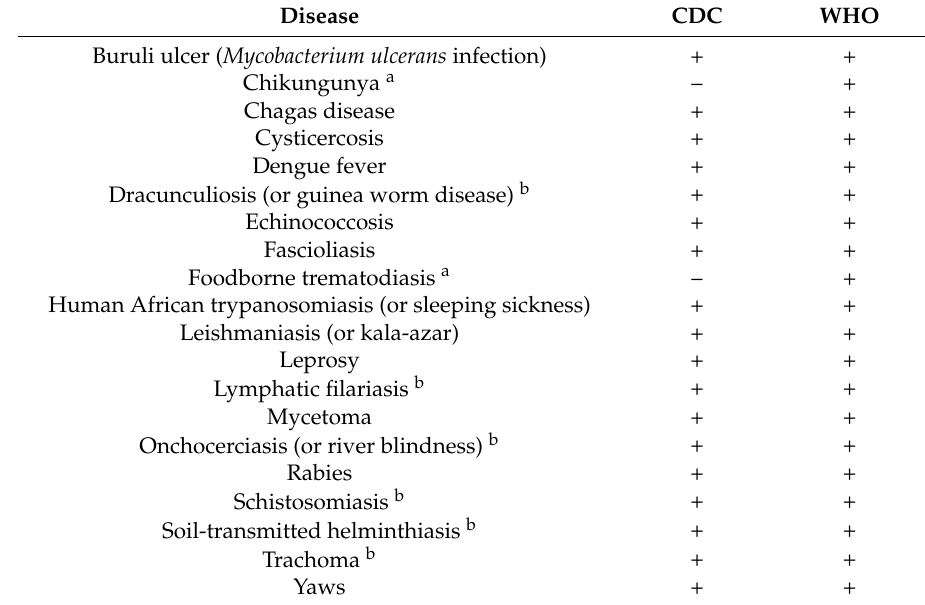
Table 1. List of Neglected Tropical Diseases by Centers for Disease Control and Prevention (CDC) and World Health Organization